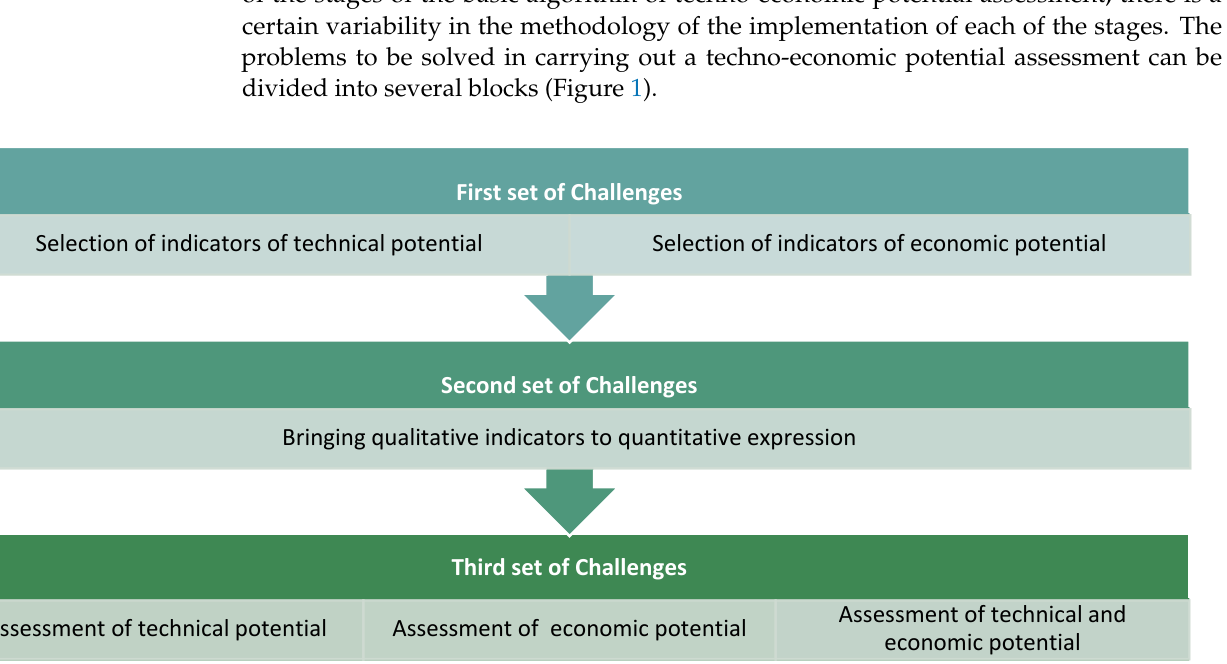
Figure 1. Methodological problems in assessing the technical and economic potential of an oil and gas field.